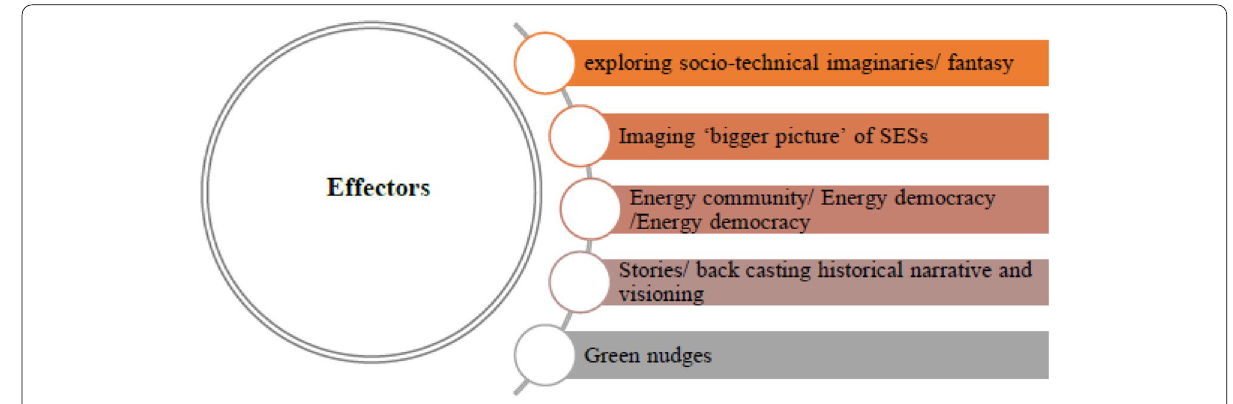
Fig. 5 Some socio-technical effectors of